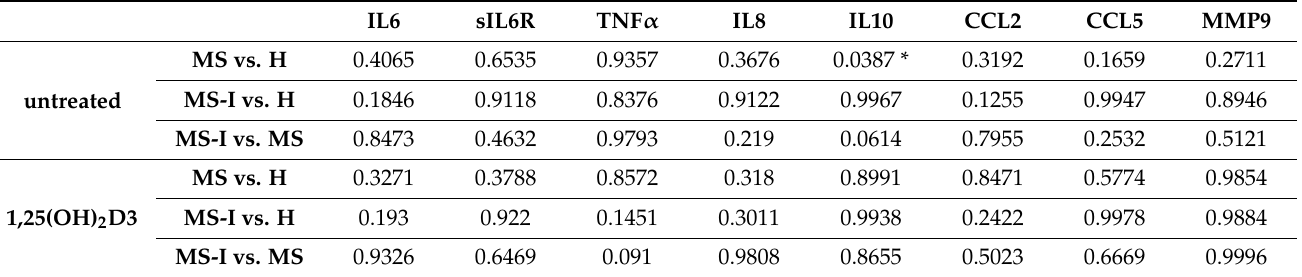
Figure 4. Expression and modulation by 1,25(OH) 2 D3 of IL10. IL10 concentrations measured in IFN-DC ( a ) and IL4-DC ( b ) supernatants from H, MS, and MS-I donors are shown as individual values. Number of subjects (n) analyzed are indicated. Black dots represent untreated cells, pink squares represent 1,25(OH) 2 D3 treated cells. 1,25(OH) 2 D3 treatment effects were tested by Student’s t-test for paired samples. Donor group effects were tested by two-way ANOVA with Tukey’s post-test for multiple comparisons. Significantly different comparison is indicated by a red bar/asterisk, * p ≤ 0.05. Table 1. Adjusted p values of the indicated comparisons of soluble mediators secreted in IFN-DC culture supernatants (Tukey’s post-test).